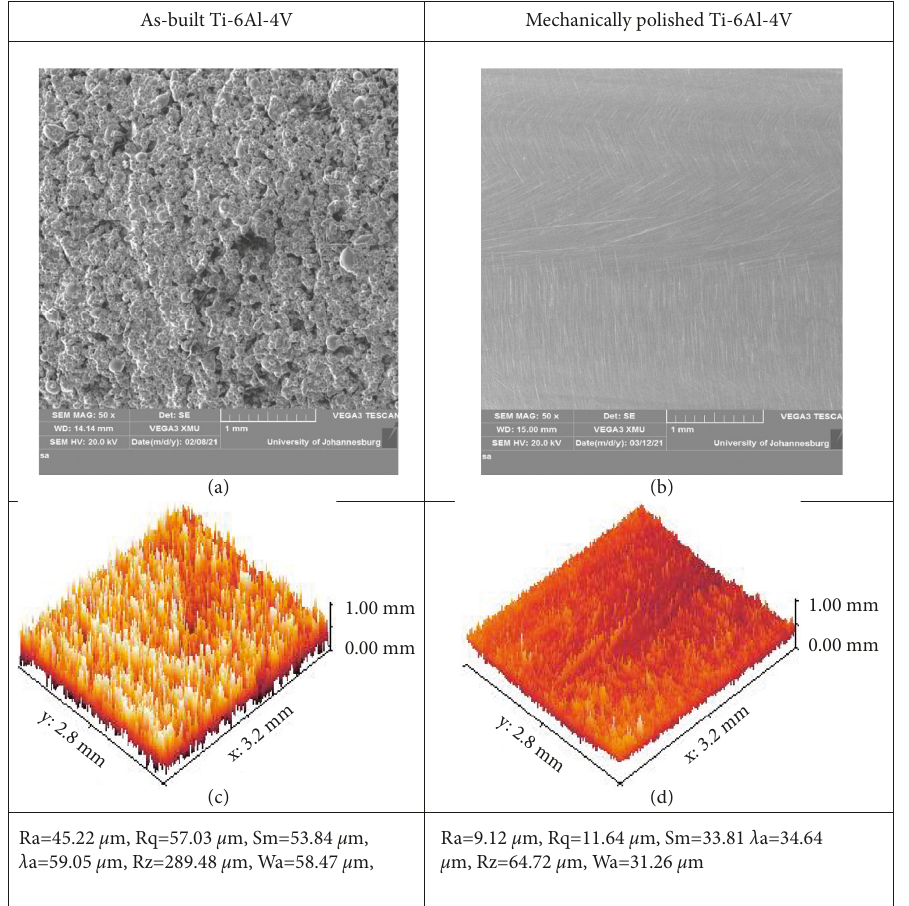
Figure 4: The SEM micrographs of (a) as-built and (b) mechanically polished and original surface profile of (c) as-built and (d) mechanically polished Ti-6Al-4V SLM built